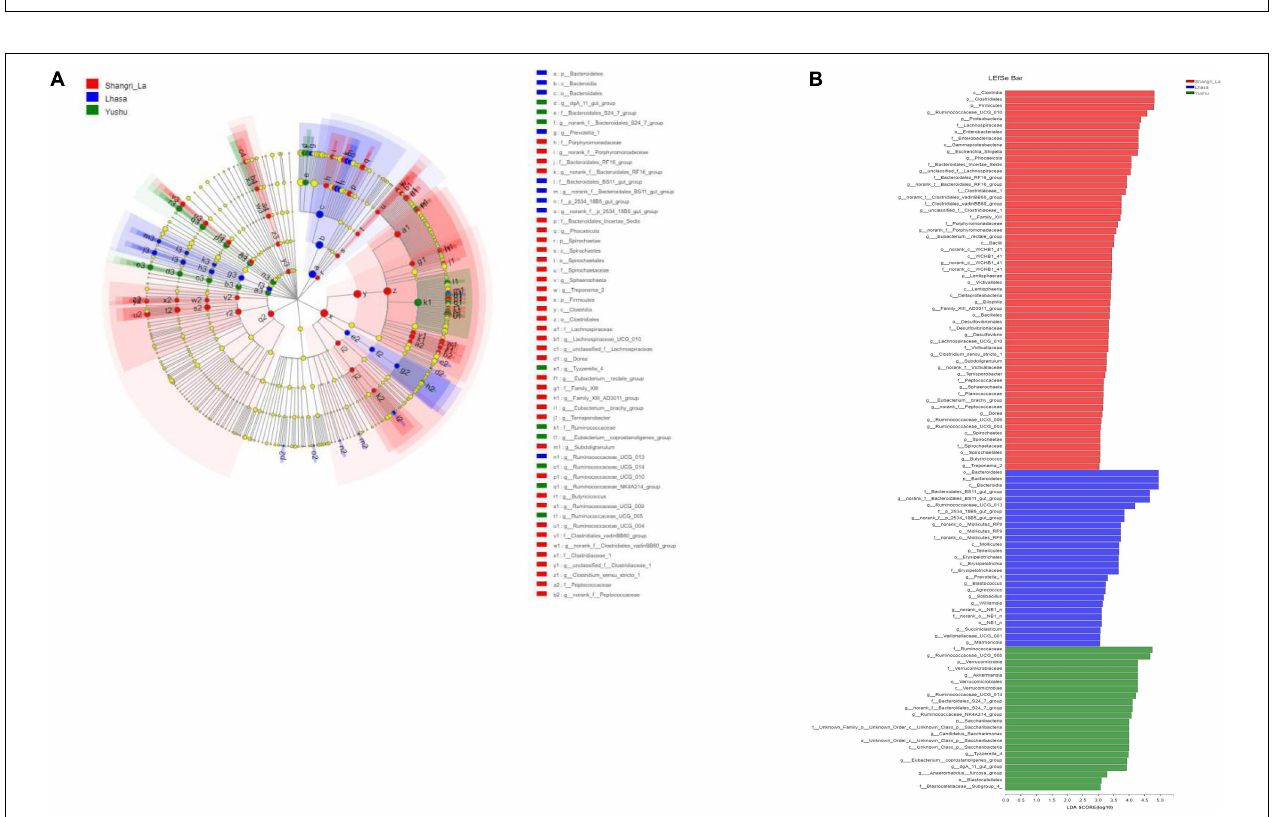
FIGURE 5 | Statistical comparison of the relative abundance of yak gut bacteria among different regions. (A) Comparison of dominant phyla in the Shangri-la, Lhasa, and Yushu groups. (B) Comparison of dominant families in the Shangri-la, Lhasa, and Yushu groups. (C) Comparison of dominant genera in the Shangri-la, Lhasa, and Yushu groups.